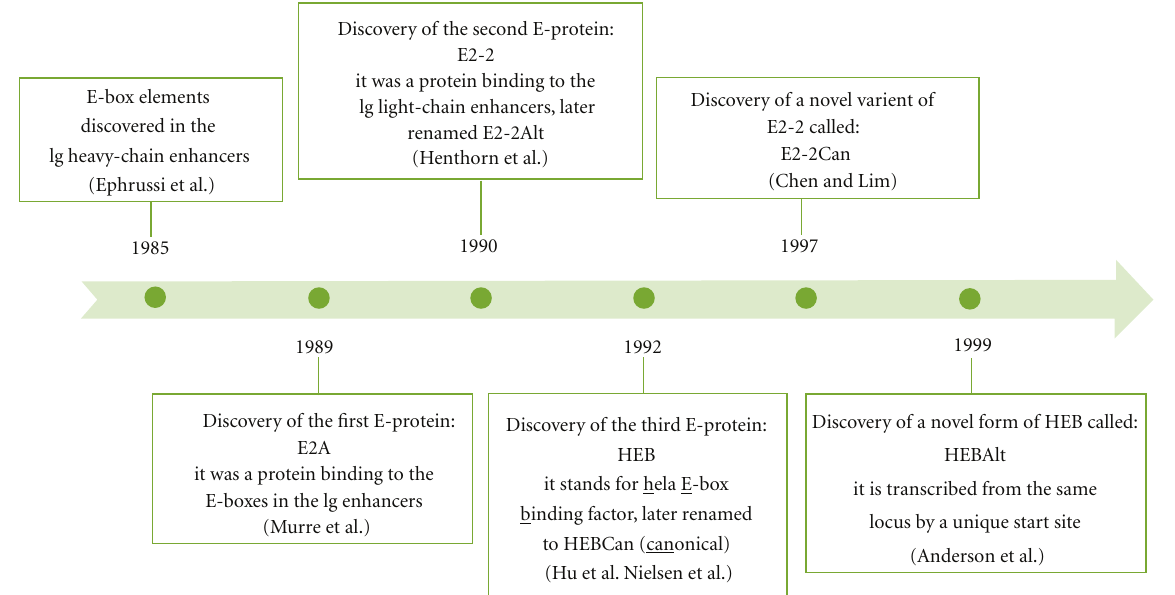
Figure 2: Timeline of E-protein discovery. In 1985, Ephrussi et al. identified regions in the immunoglobulin (Ig) heavy chain gene enhancer ( μ E1– μ E5) that were occupied by unidentified DNA-binding proteins in the B-cell lines, but not in nonlymphoid cells [62]. The regions had a CANNTG consensus sequence, which was later named an E-box. In 1989, Murre et al. discovered that E-boxes in the Ig-heavy and light-chain enhancers were occupied by two novel proteins, which they named E47 and E12 [63]. These were the first E-proteins discovered, so called because they bind to the E-box sites. In 1990, the search for transcription factors that bind Ig light-chain enhancer sites ( κ E1– κ E3) revealed a second E-protein, ITF-2A [64], later named E2-2Alt [65]. Concurrent studies by Hu et al. involved the use of the μ E2 sequence to screen a cDNA library from HeLa cells, a human cell line, which led to the discovery of the third E-protein in 1992 [66]; the mouse counterpart was discovered later that year [67]. This protein was named HEB (HeLa E-box binding factor). In 1997, a splice variant of E2-2 was identified [68] and named ITF-2b (now called E2-2Can), which in contrast to E2-2Alt had an inhibitory e ff ect on the promoter of a muscle-specific gene [69]. In 1999, Anderson et al. set out to identify transcription factors involved in T-cell specification by screening a SCID (severe combined immunodeficient)-thymocyte cDNA library. The search revealed a novel HEB clone [70], which was transcribed from the HEB locus from its own transcriptional start site located near a unique alternative (Alt) exon, homologous to E2-2Alt [71]. The presence of the Alt exon resulted in naming this E-protein HEBAlt, and referring to the canonical HEB as